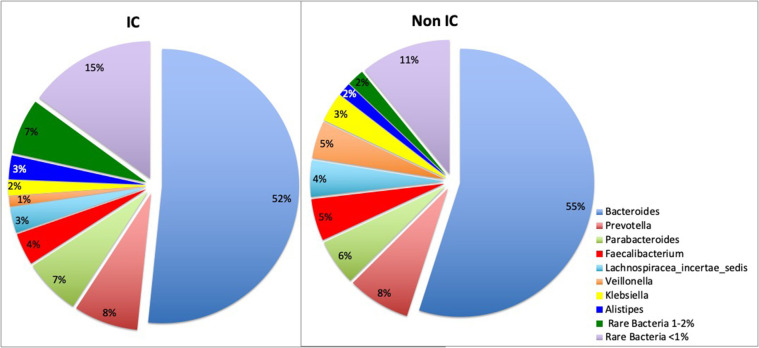
Pie charts represent total percentage read counts in the IC and non-IC groups for the corresponding color-coded genera with major genera including Bacteroides, Prevotella, Parabacteroides, Faecalibacterium, Lachnospiracea_incertae_sedis, Veillonella, Klebsiella, Allistipes. Other minor genera were regrouped as “rare bacteria comprising 1–2%” and “rare bacteria comprising < 1%” of total read counts.